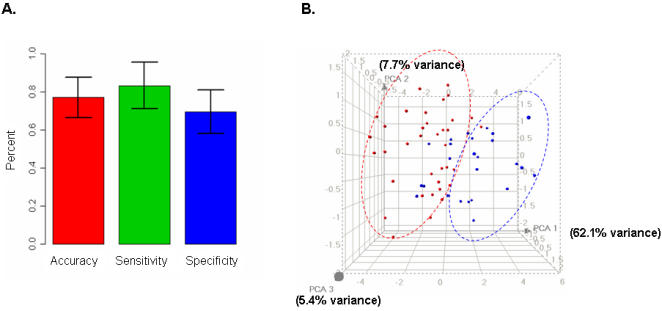
A set of 41 classifier genes were identified via 10-fold cross-validation on the 61-sample training set.(A). Classification accuracy, sensitivity and specificity of the 41 classifier genes, error bar represents±1 standard deviation among 100 times of independent 10-fold cross-validation process; (B). 3D Plots of the first three principal components based on PCA analysis. The segregation between TAA and control samples is evident with only a few exceptions.